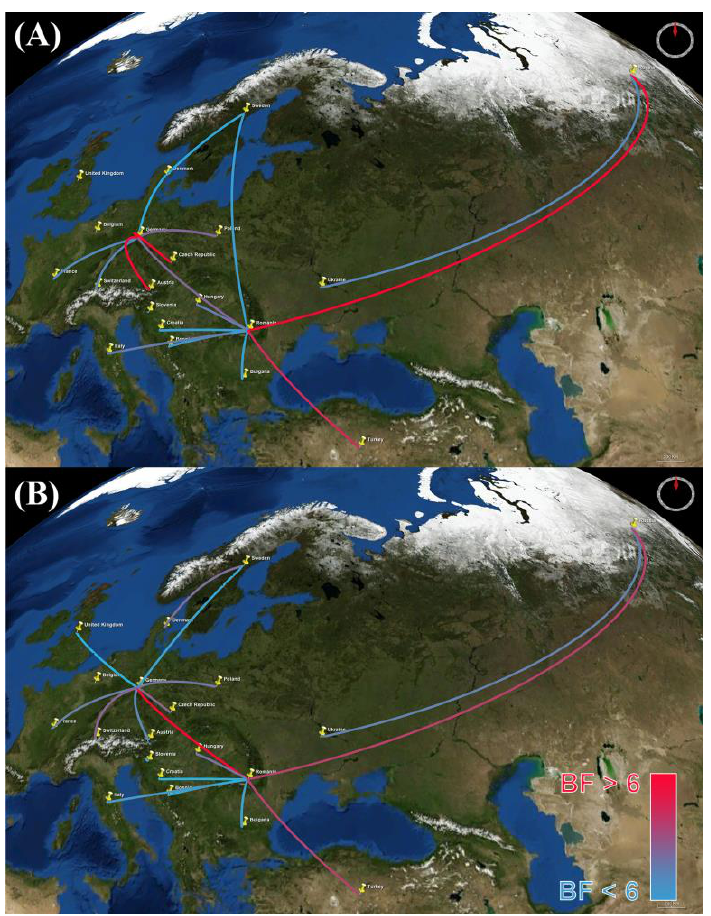
Figure 5. Bayes factor (BF) test for significant non-zero dispersal rates in H5N1 HPAIV. Only rates supported by a BF greater than six are indicated. The color gradient of lines correspond to the probability of the inferred dispersal routes; blue lines and red lines indicate relatively weak and strong support, respectively. The maps are based on satellite pictures available in Google Earth (Available online: http://earth.google.com). ( A ) HA gene; ( B ) NA gene. The maps are based on satellite images sourced from the NASA World Wind Java SDK (Available online: http://worldwind.arc.nasa.gov/java/).